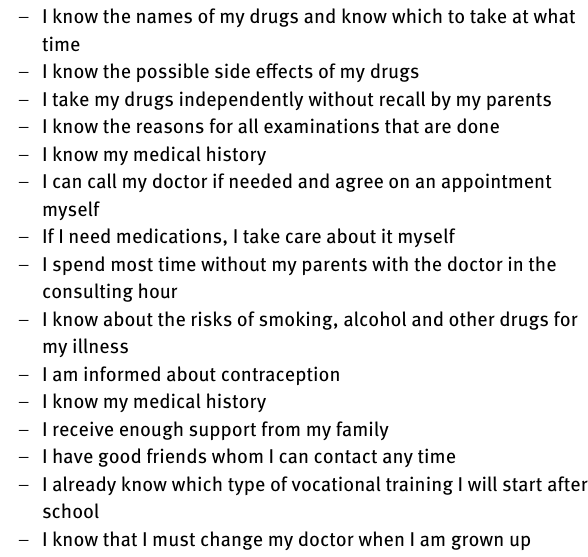
Table 2: Standardized informing interview for the 15–17 year olds (modified according to ref. [9,